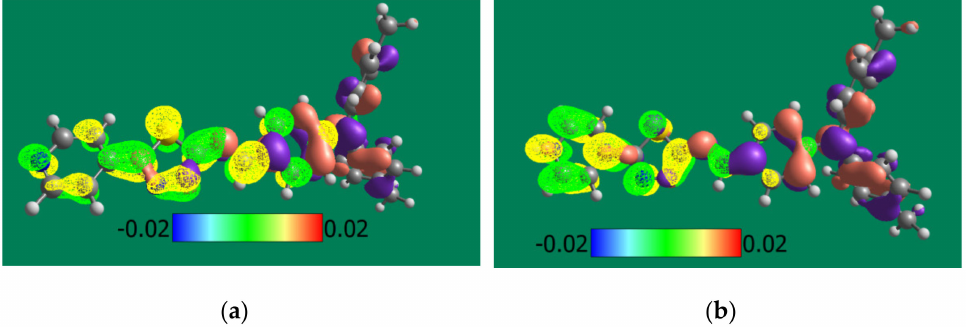
Figure 6. Modeled HOMO (brown and purple) and LUMO (yellow and green) orbitals for trans -PPL9 ( a ) and H + doped trans -PPL9 ( b ) molecule. Brown and yellow lobes correspond to positive-, whereas purple and green lobes—to negative isosurface values.